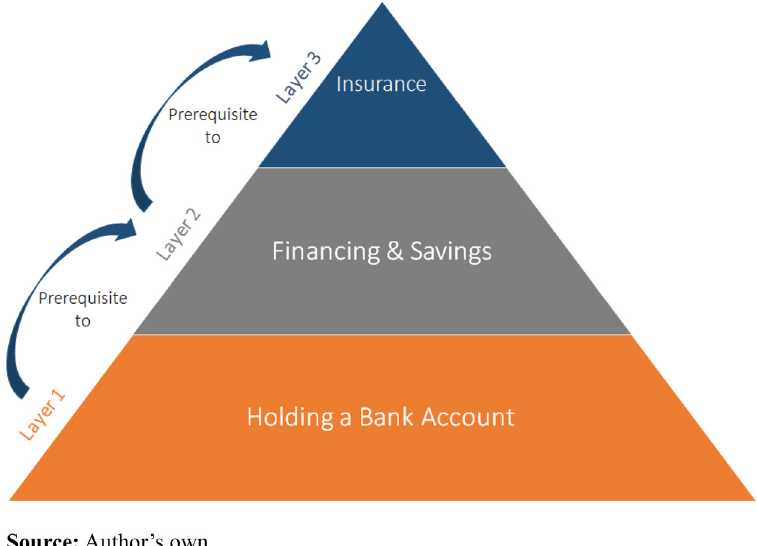
Figure 3. Layers of fi